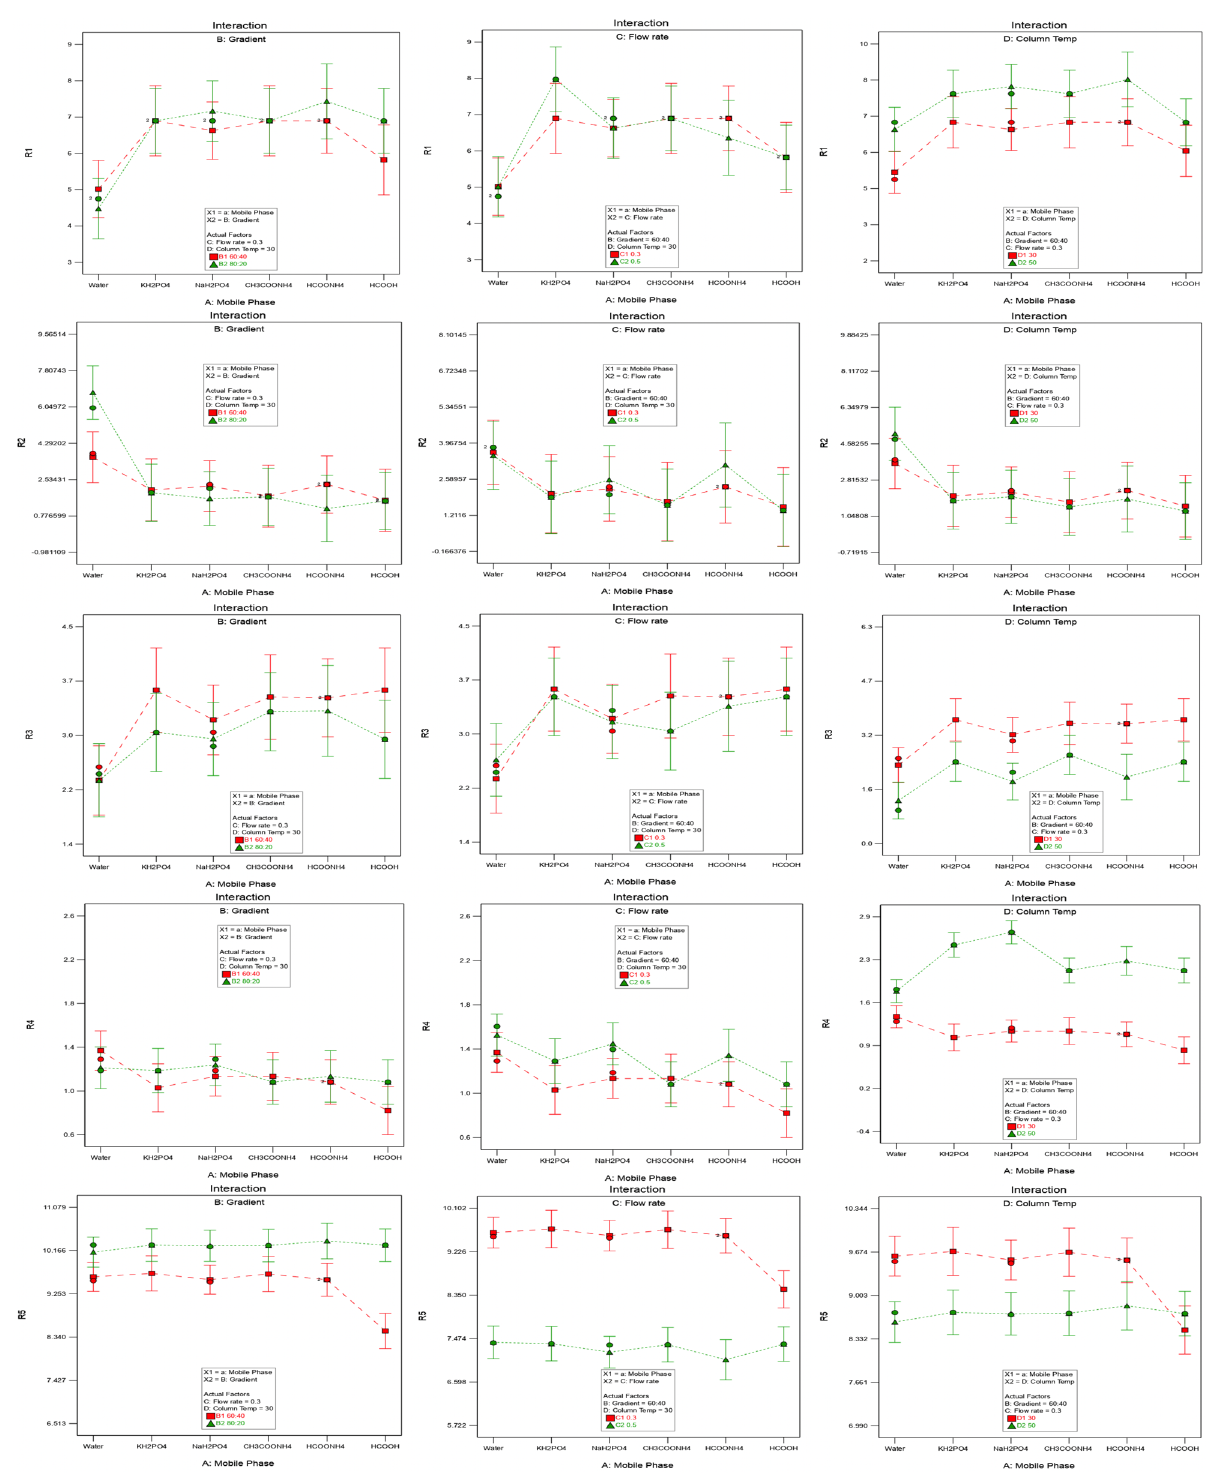
Figure 1. Interaction effect plots from the screening D-optimal split-plot design. R1: Number of impurity peaks separated with a minimum resolution of 1.5; R2: Rs between Imp-H and MPM; R3: Rs between MPM and Imp- D; R4: Rs between Imp-D and Imp-F; and R5: Rt of the late eluting